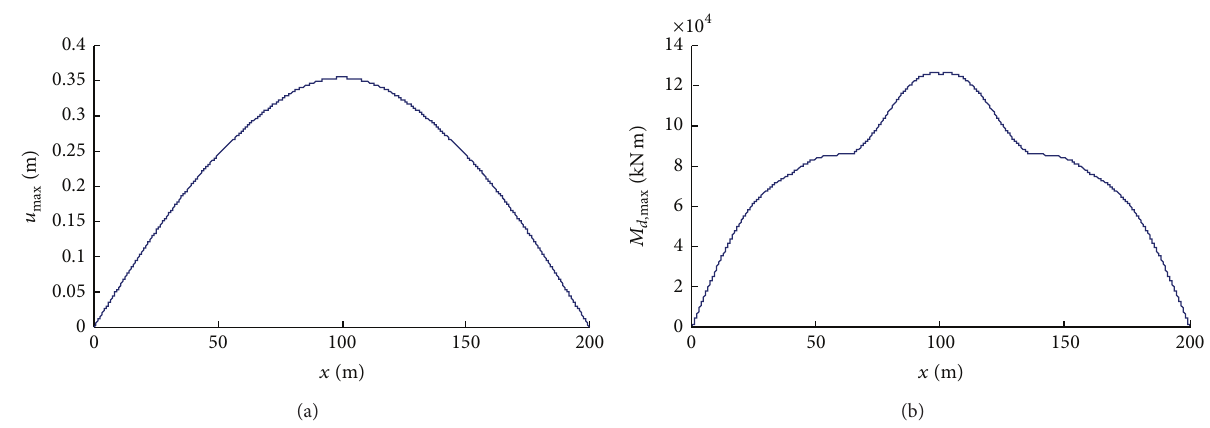
Figure 5: Average peak transverse displacements 𝑢 max (a) and bending moments 𝑀 𝑑, max (b) along the deck.